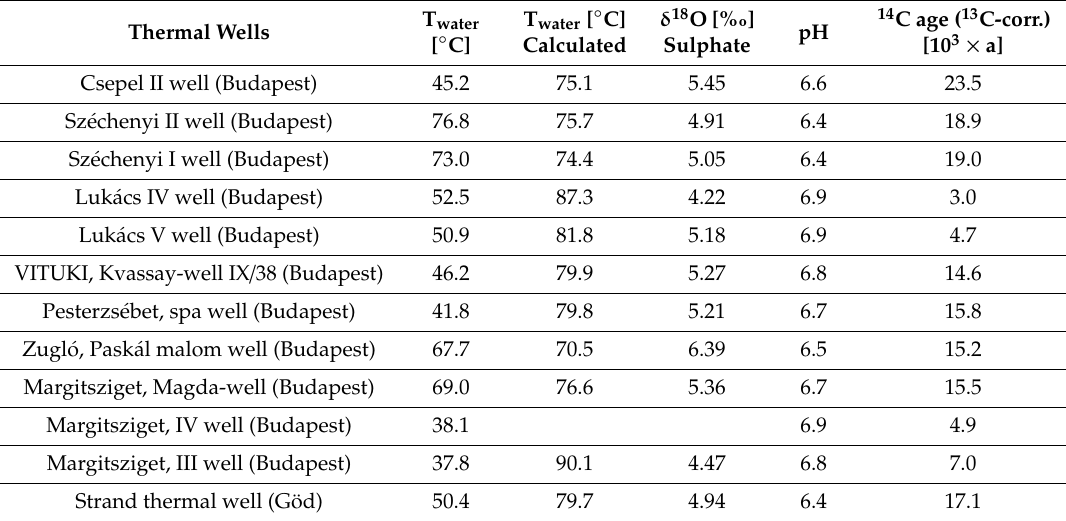
Table 3. The temperatures measured (T water ), thermometer temperatures (T water calculated), oxygen isotopic composition of dissolved sulphate, pH and 13 C-corrected radiocarbon ages of thermal